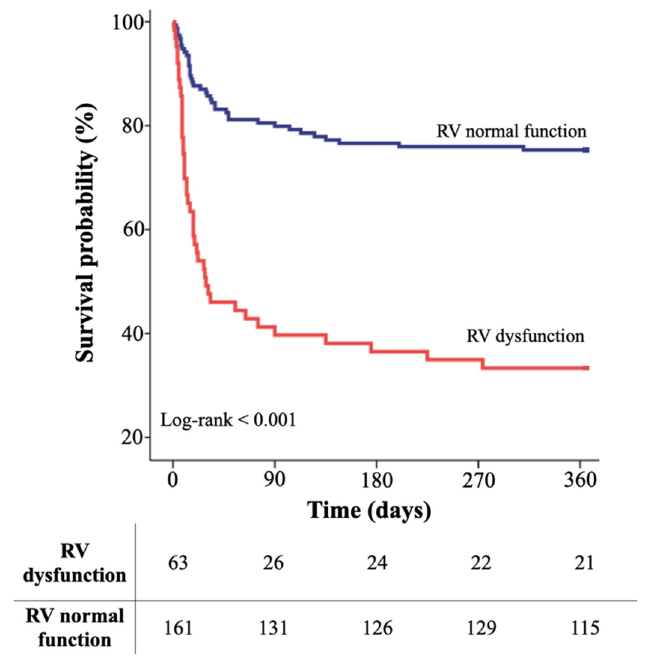
Figure 1. Kaplan–Meier curves for survival free from all-cause death in RV dysfunction (red line) vs. normal RV function (blue line) group.